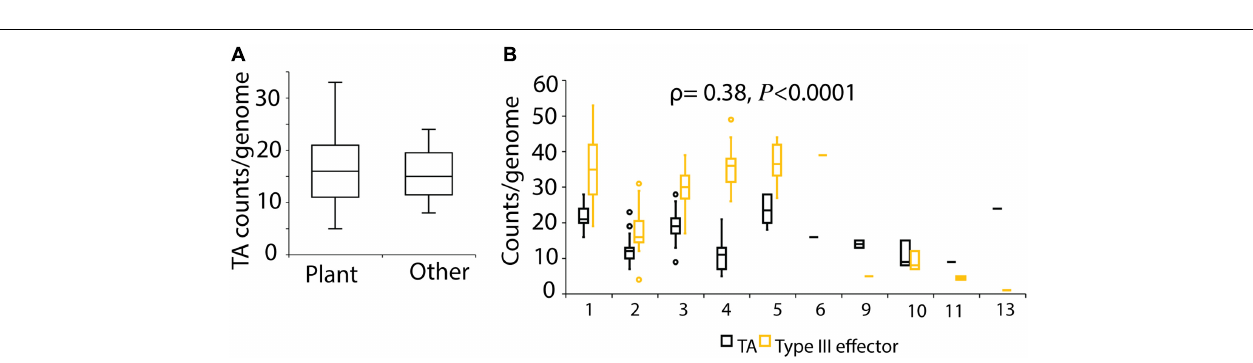
FIGURE 3 | (A) Association of TA counts by genome size and (B) plasmid counts. (C) Heatmap showing occurrence of all 260 homologs of TA systems in the 28 completely sequenced strains in chromosome or plasmids. Most TA systems were encoded in the chromosome.